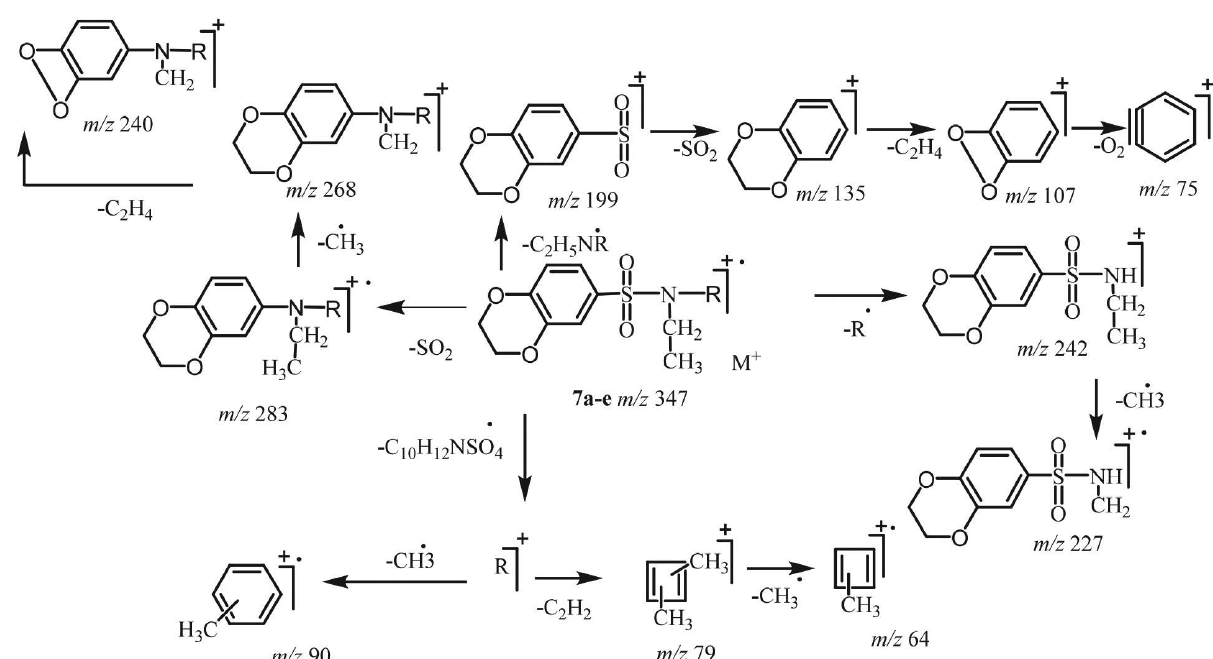
Figure 3. Mass fragmentation pattern of N -ethyl- N -(dimethylphenyl)-2,3-dihydrobenzo[1,4]dioxine-6-sulfonamide 7a –